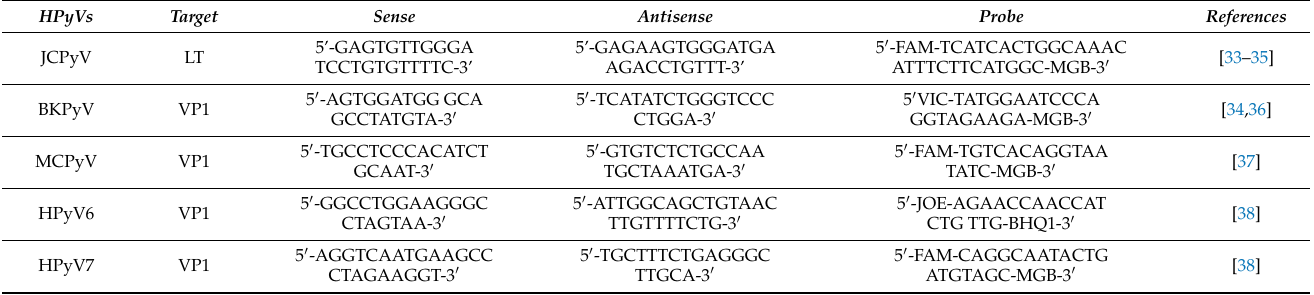
Table 2. Primers employed in qPCR to detect and quantify JCPyV , BKPyV , MCPyV , HPyV6 and HPyV7 DNA